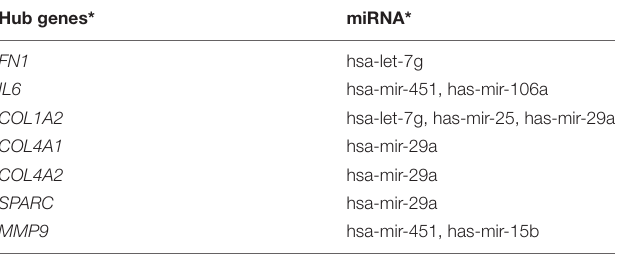
TABLE 4 | Hub genes and the associated altered miRNA.